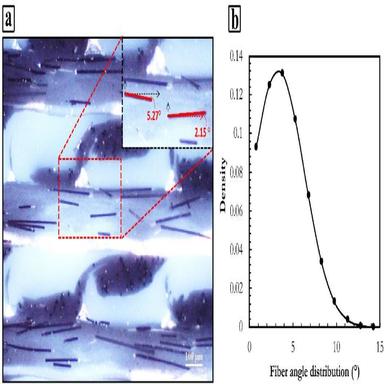
Cross-sectional view of microstructure of fiber reinforced FGM sample that is used to estimate the fiber orientation distribution with respect to the printing direction, (a) micrography of the FGM part, (b) fiber angle distribution.